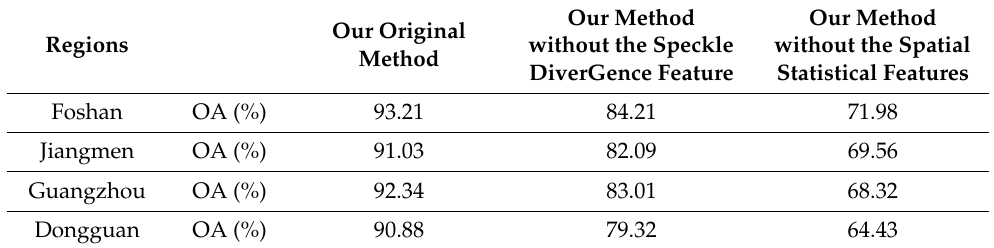
Table 8. BAs extraction accuracy of the proposed method with different